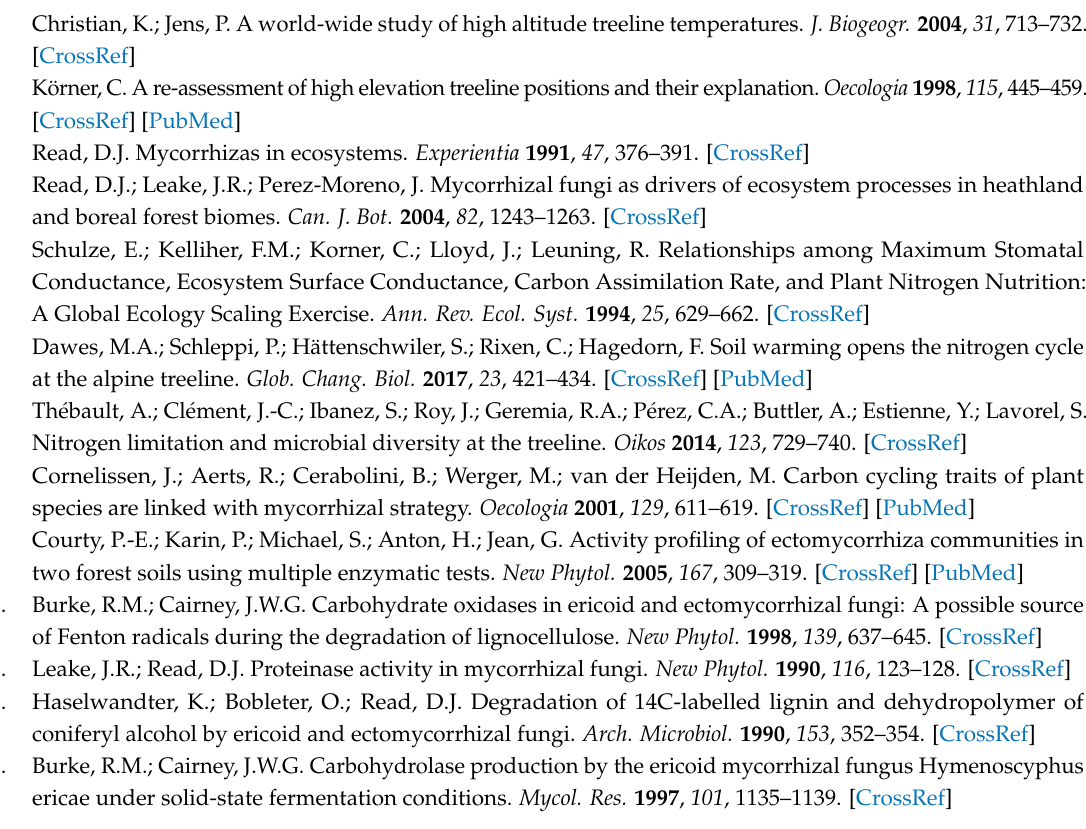
Table S1: Extracellular enzymes, their activities in soil, and the two fluorometrically labelled assays (4-methylumbelliferone-MUF and 7-amino-4-methyl coumarin-AMC) containing substrates used in the present analysis; Table S2: Identification of ectomycorrhizal taxa associated with Picea abies at tree line (1668 to 1791 m). Table S3: β -glucosidase, Acid phosphatase, Cellobiohydrolase, and β -xylosidase activity on root tips of 10 different ectomycorrhizal taxa of Picea abies at tree line (1668 to 1791 m). Figure S1: Images of the tree line site (1668 to 1791 m) at Wasserberg in the central Alps, Austria; Figure S2: Profile of ericoid mycorrhizal roots collected from the tree line (1668 to 1791 m) at Wasserberg in the central Alps, Austria in June 2016; Figure S3: Ericoid mycorrhizal roots